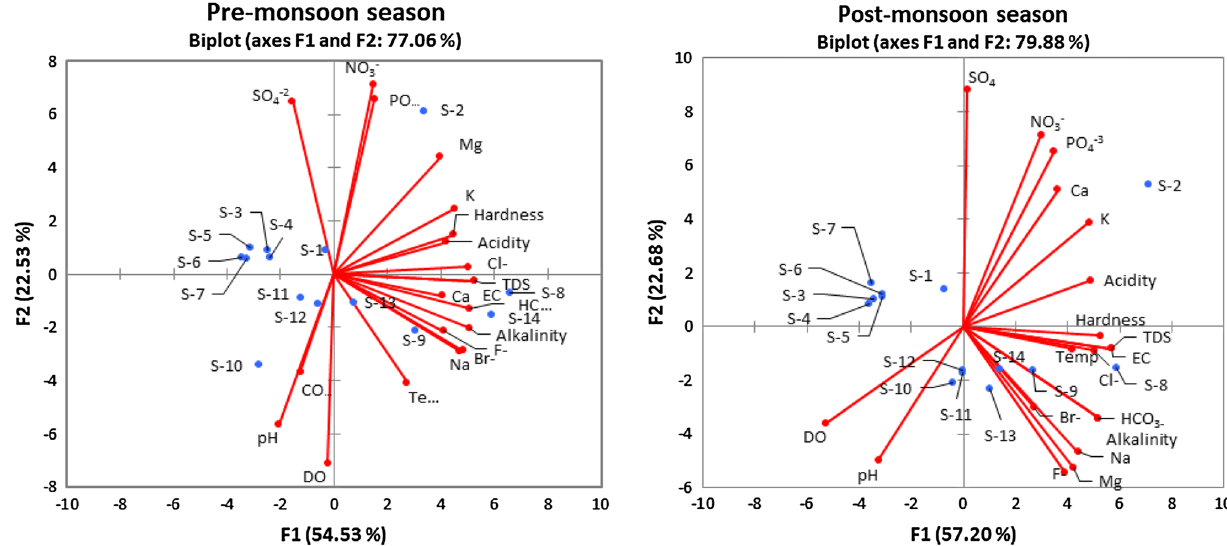
Fig. 6 Biplots of the water quality variables of pre-monsoon and post-monsoon